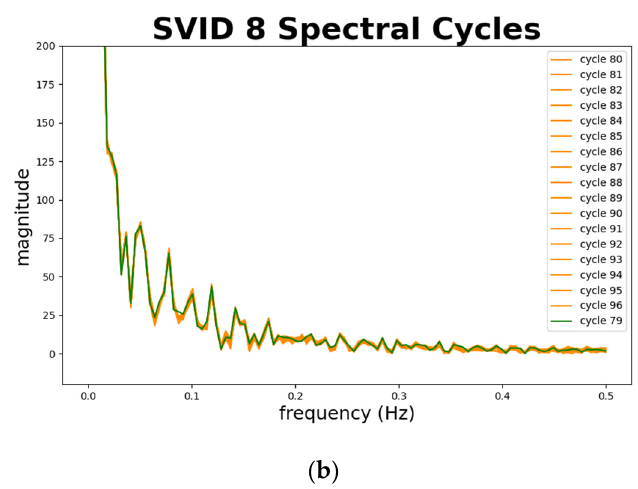
Figure 14. Normal sequences in spectra from 2 SVIDs: ( a ) 7th SVID; ( b ) 8th SVID.